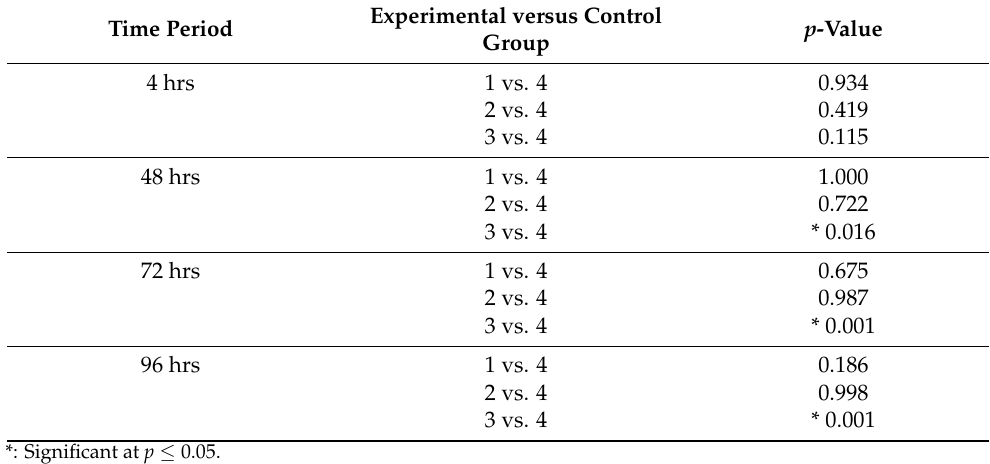
Table 3. Comparison of experimental groups versus Control group (Group 4) using Dunnett’s Test.